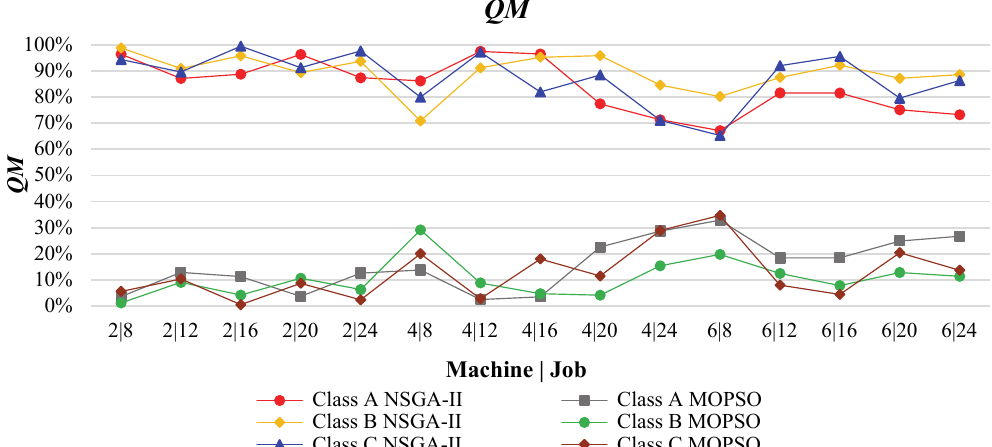
Fig. 11. QM criterion for the two algorithms in the small scale sample problems